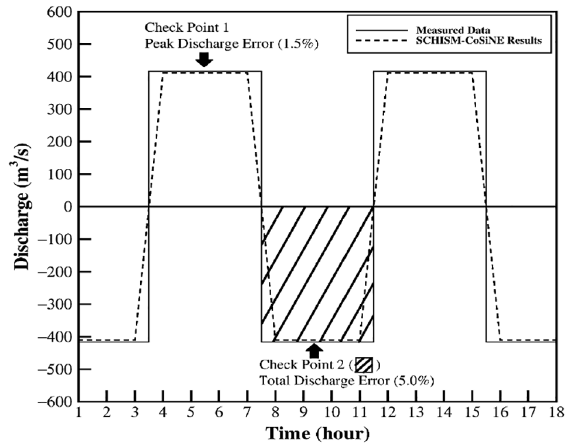
Figure 5. Comparisons of SCHISM-CoSiNE results and measured data about discharge of input and output